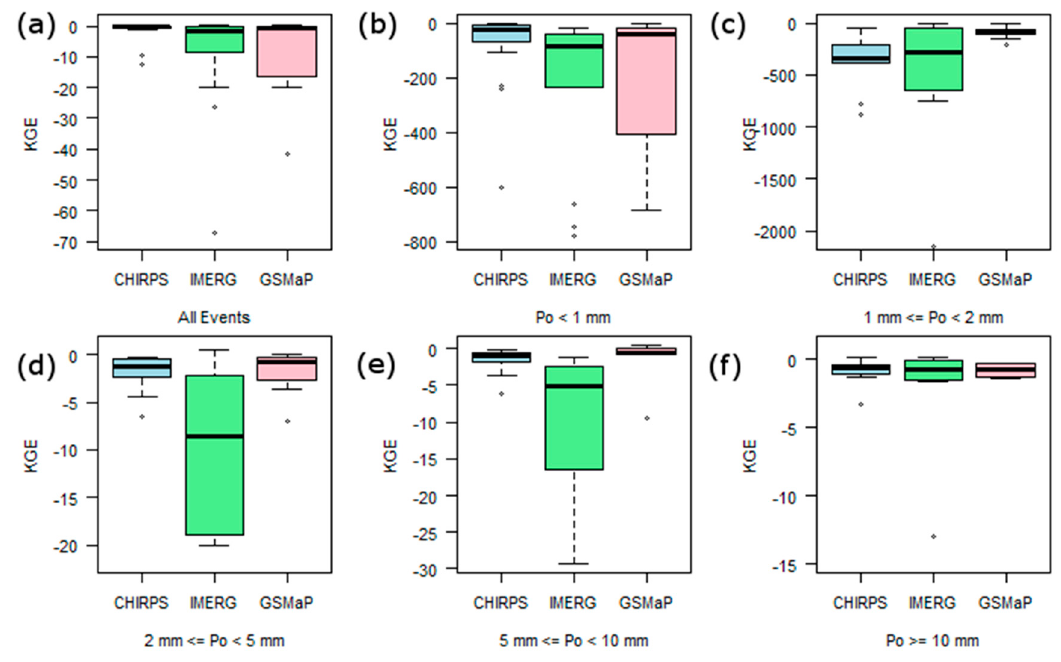
Figure 6. Box plots of Kling–Gupta efficiency (KGE) of the three satellite-based datasets in the estimation of rainfall amount for ( a ) all events, and ( b – f ) different intensity ranges as shown in the corresponding plot.